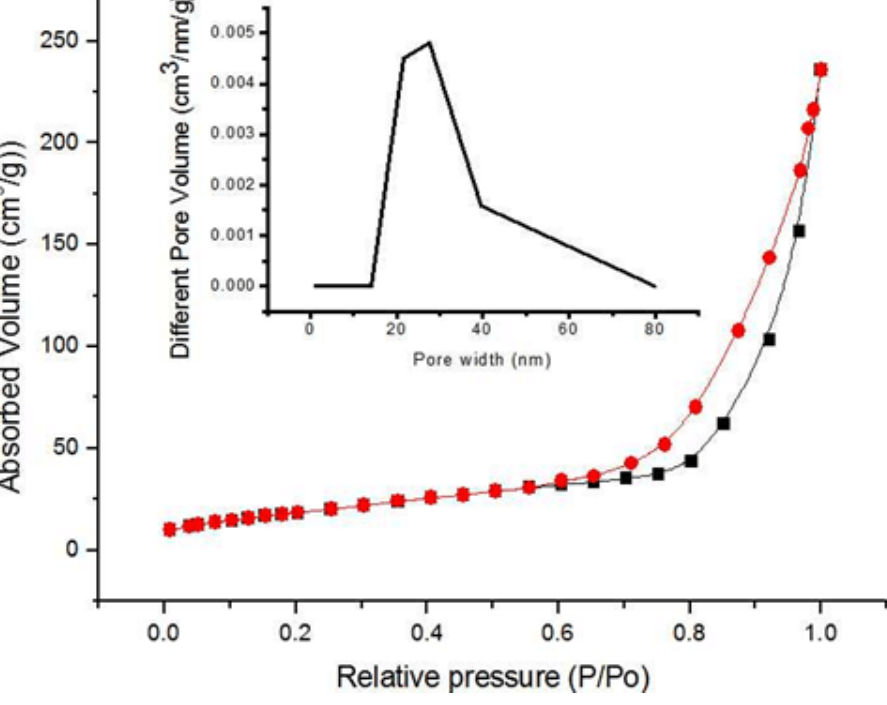
Figure 4. N 2 adsorption/desorption isotherms of the CNF-PtNP hybrids as well as the pore size